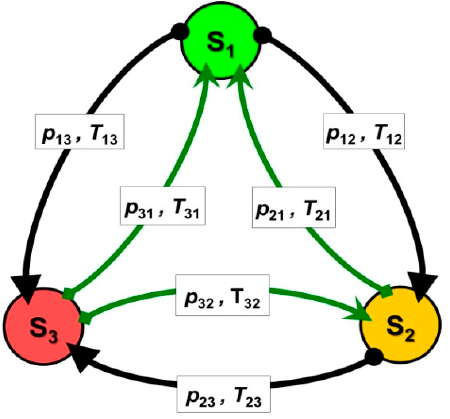
Figure 10. Ship’s main engine state change graph: s 1 —full effective operability, s 2 —partial operability, s 3 —inoperability. p ij —probability of process transition from s i to s j , T ij —duration of s i provided that process transition to s j , i , j = 1, 2, 3.